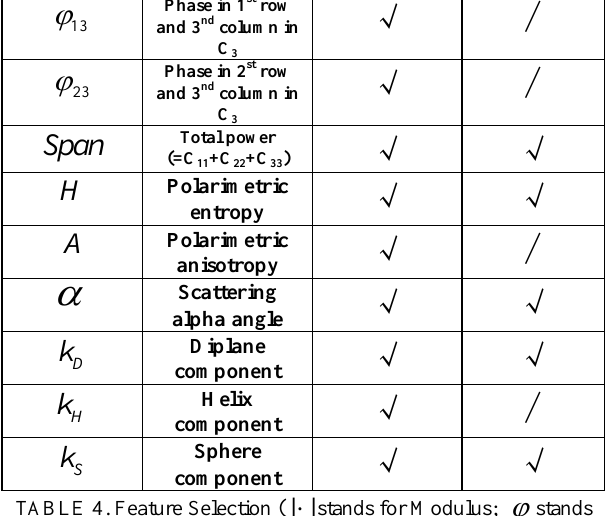
TABLE 4. Feature Selection ( | |  stands for Modulus;  stands for Phase;